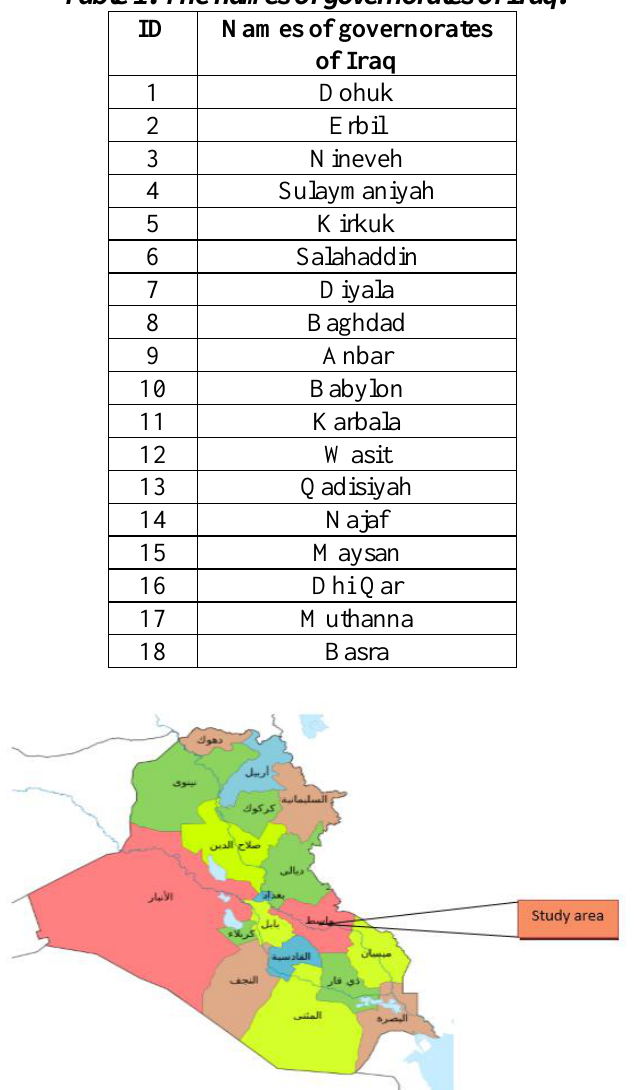
Table 1: The names of governorates of Iraq.